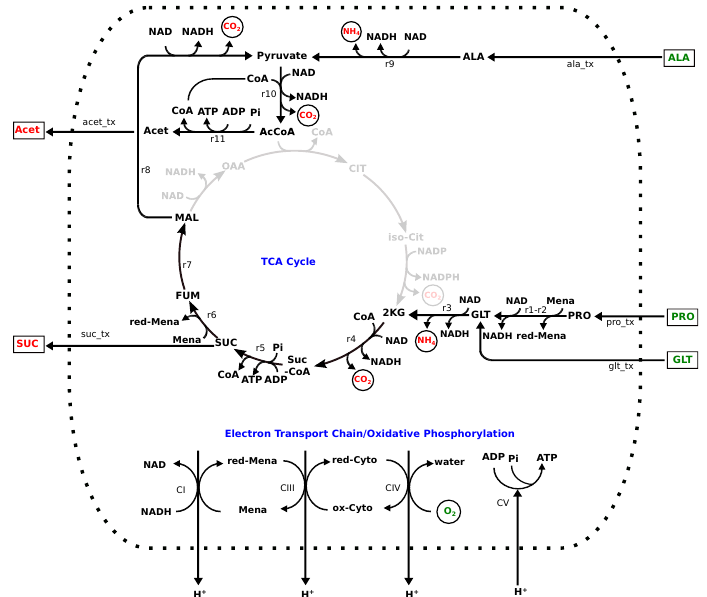
Figure 3. Linear programming solution with the constraint on ATPase flux, cell maintenance cost computed on MHHW medium, in the absence of demand for biomass precursors. All components of the MHHW medium, described above, were assumed to be present. Compounds in green (Pro, Ala, Glt, O 2 ) are imported and those in red (Suc, Ac, CO 2 and NH 4 ) are exported. Reaction labels are